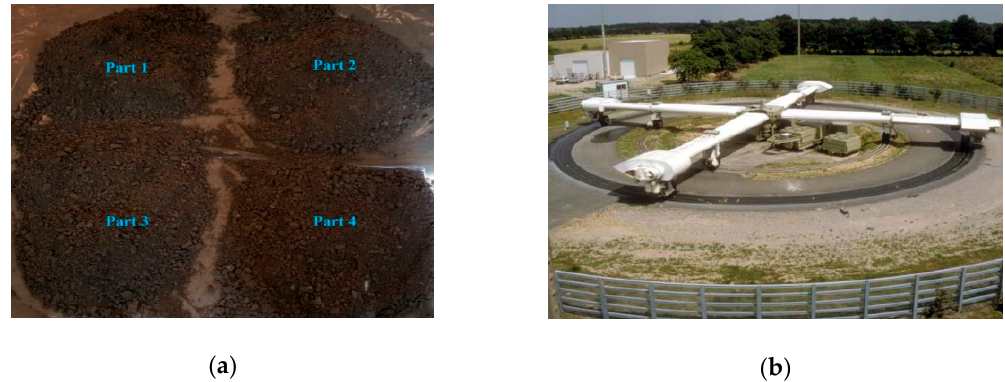
Figure 1. UGM Br é fauchet: ( a ) uniformizing the material; ( b ) IFSTTAR full-scale test Figure 1. UGM Bréfauchet: ( a ) uniformizing the material; ( b ) IFSTTAR full-scale test track.